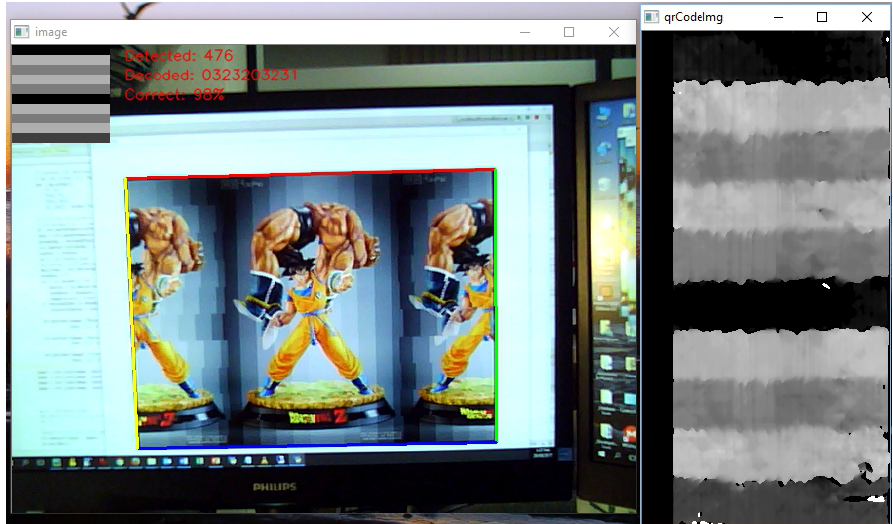
Figure 14. Screenshot 1 of the tag detection and